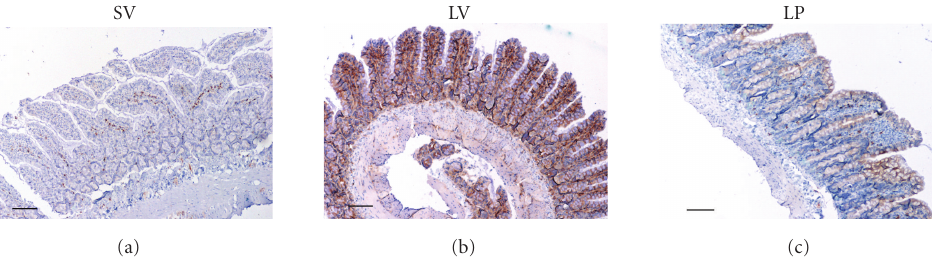
Figure 2: Expression of NF- κ B p65 in the small intestines in SV group (sham + vehicle, n = 6), LV group (lesion + vehicle, n = 6), and LP group (lesion + progesterone, n = 6). (a) Rats of SV group showing low NF- κ B p65 immunoreactivity; (b) Rats of LV group showing increased NF- κ B p65 immunoreactivity stained as brown; (c) Rats of LP group showing less NF- κ B p65 immunoreactivity than LV group (scar bar, 100 μ